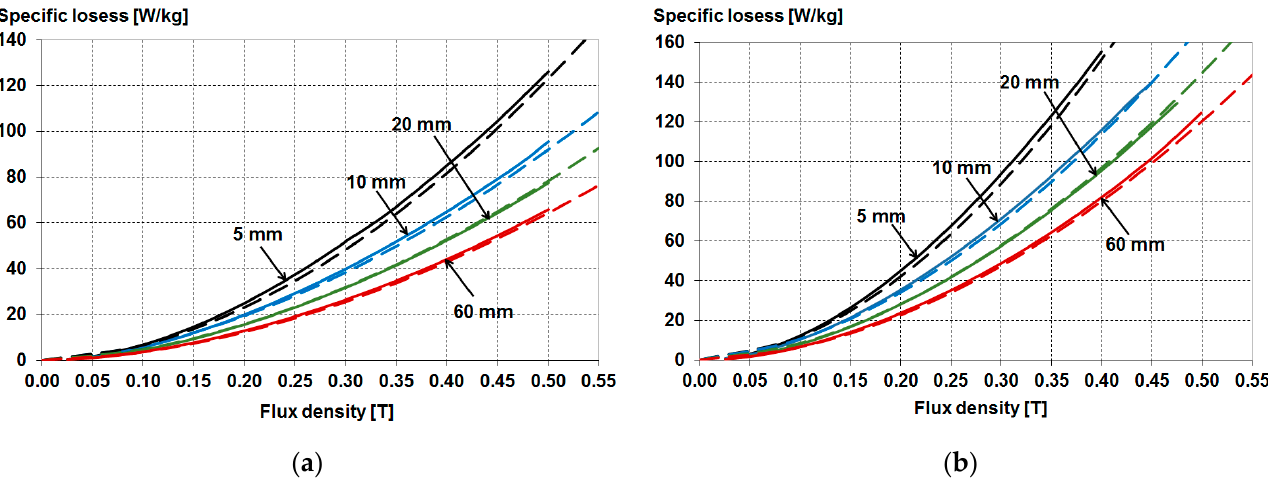
Figure 25. Measured and approximated loss characteristics of the M 270-35A sheet for various widths of the sheet samples at the frequency of 2000 Hz ( a ) and 3000 Hz ( b ) (measured—solid line, estimated—dashed line).